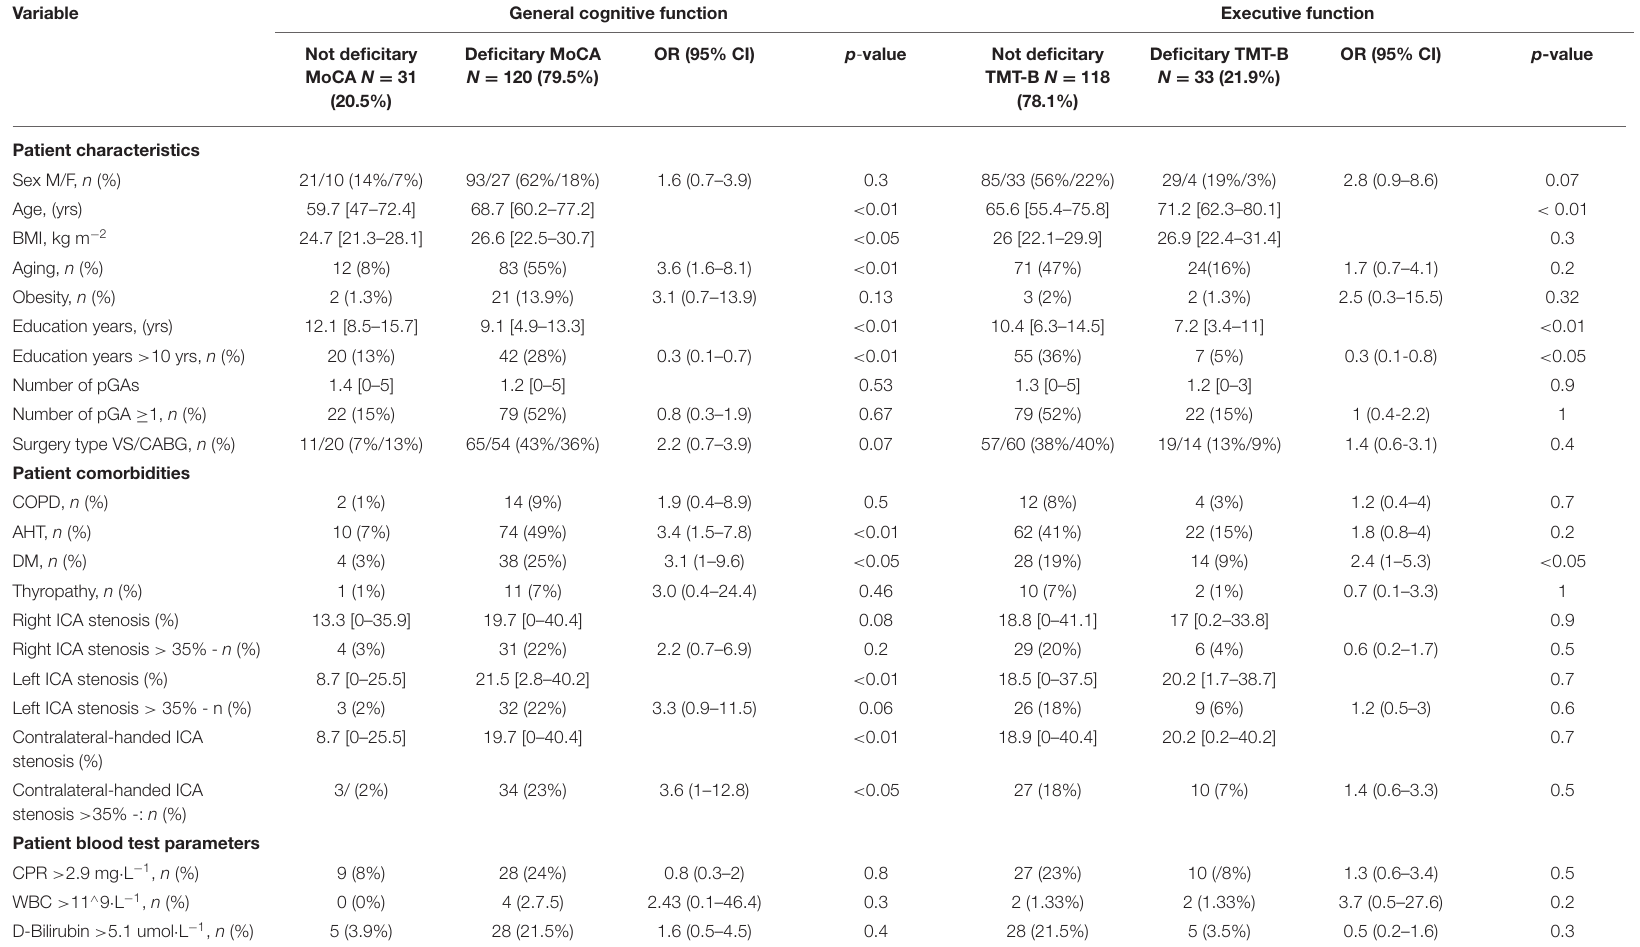
TABLE 2 | General patient, drug, and monitoring characteristics based on baseline cognitive